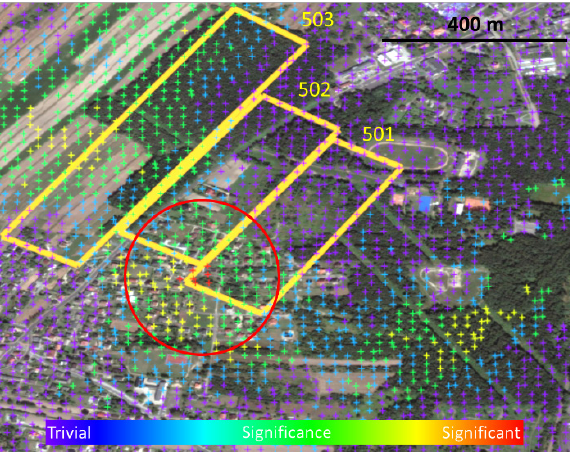
Figure 18. Movement significance map. Red circle, hotspot with high